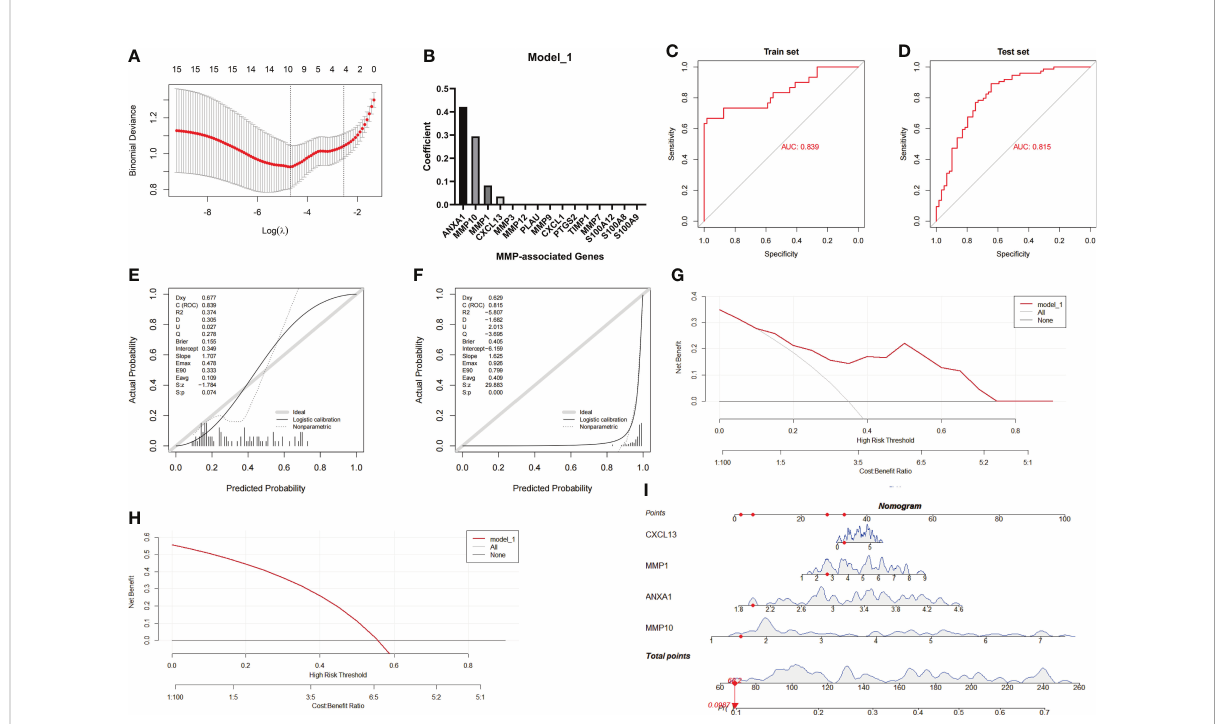
FIGURE 5 Establishment and evaluation of Model_1 with the MMP-associated module. (A) Selection of the optimal parameter (lambda) in the LASSO model. (B) Plot of coef fi cients obtained by LASSO. ROC curve (C, D) , calibration curves (E, F) , and decision curve analysis (DCA) (G, H) of the training and testing cohort models. (I) Nomogram of Model_1 for the predictive value of CD/UC is